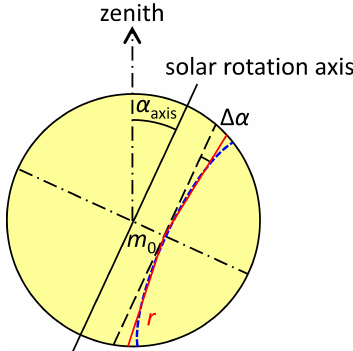
Figure 2. Conversion of solar shift to radial mispointing. m axis des- ignates the apparent distance from the solar equator. Blue: mean conversion factor given in Gisi et al. (2011). Green: iteratively de- termined mean conversion for the Zugspitze data set according to Eq. (3). Black: conversion according to Eq. (2), using ω(ϕ) values calculated with Eq. (1), m axis calculated using Eq. (3). Red: best fit linear conversion according to Eq. (4).